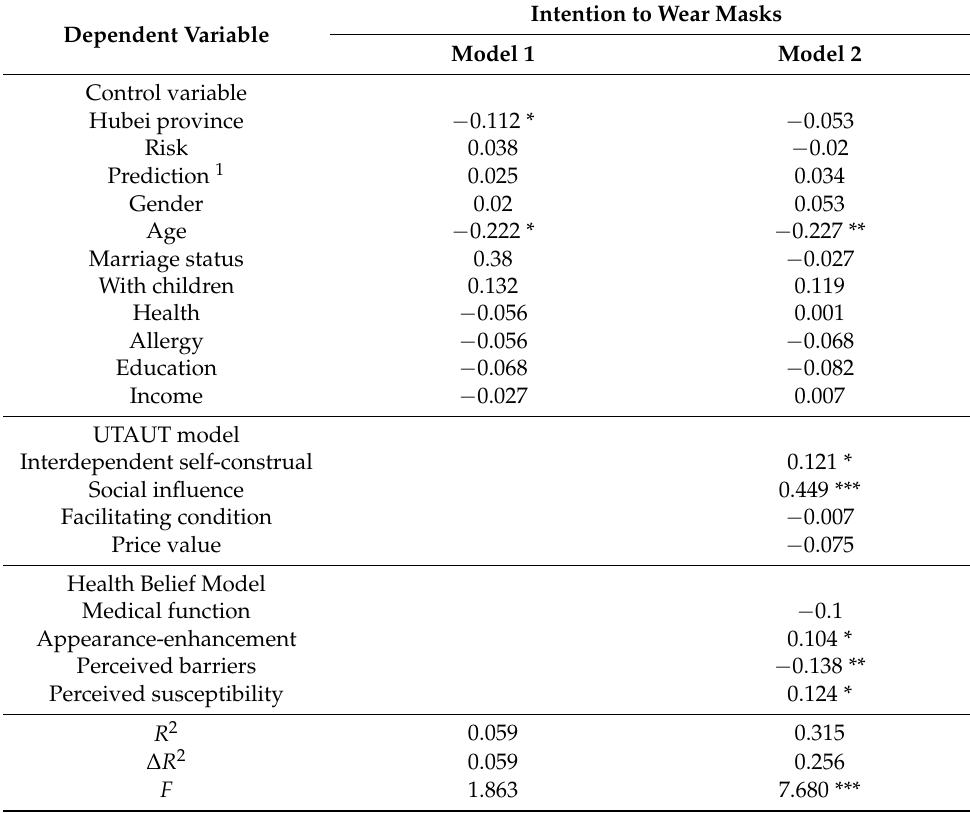
Table 3. Results of hierarchical regression analysis.